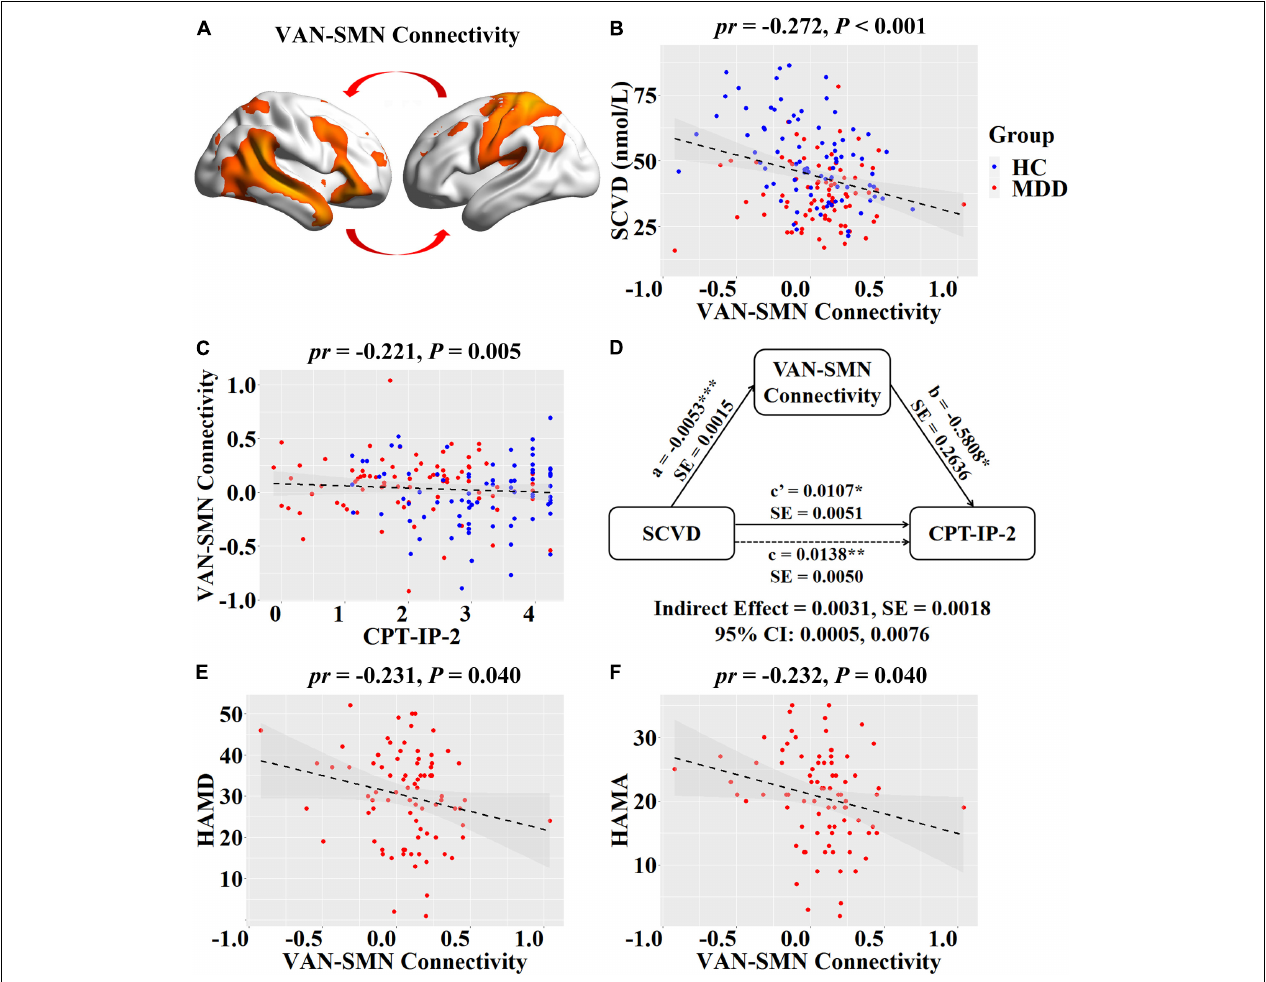
FIGURE 2 | Associations between SCVD, internetwork functional connectivity, and clinical variables in females. (A) Female patients and controls differed in functional connectivity between VAN and SMN. (B) A scatter plot shows correlation between SCVD and VAN-SMN connectivity in females. (C) A scatter plot shows correlation between VAN-SMN connectivity and CPT-IP-2 in females. (D) Graphical representation of the mediation analysis between SCVD and CPT-IP-2 in females with VAN-SMN connectivity as mediator: estimates of the mediated ( a × b ), direct ( c (cid:48) ), and total (c) effects. (E,F) Scatter plots show correlations of VAN-SMN connectivity with HAMD and HAMA scores. * P < 0.05, ** P < 0.01, *** P < 0.001. SCVD, serum concentration of vitamin D; VAN, ventral attention network; SMN, sensorimotor network; CPT-IP, Continuous Performance Task-Identical Pairs; HAMD, Hamilton Rating Scale for Depression; HAMA, Hamilton Rating Scale for Anxiety; HC, healthy controls; MDD, major depressive disorder; pr , partial correlation coefficient; SE, standard error; CI, confidence